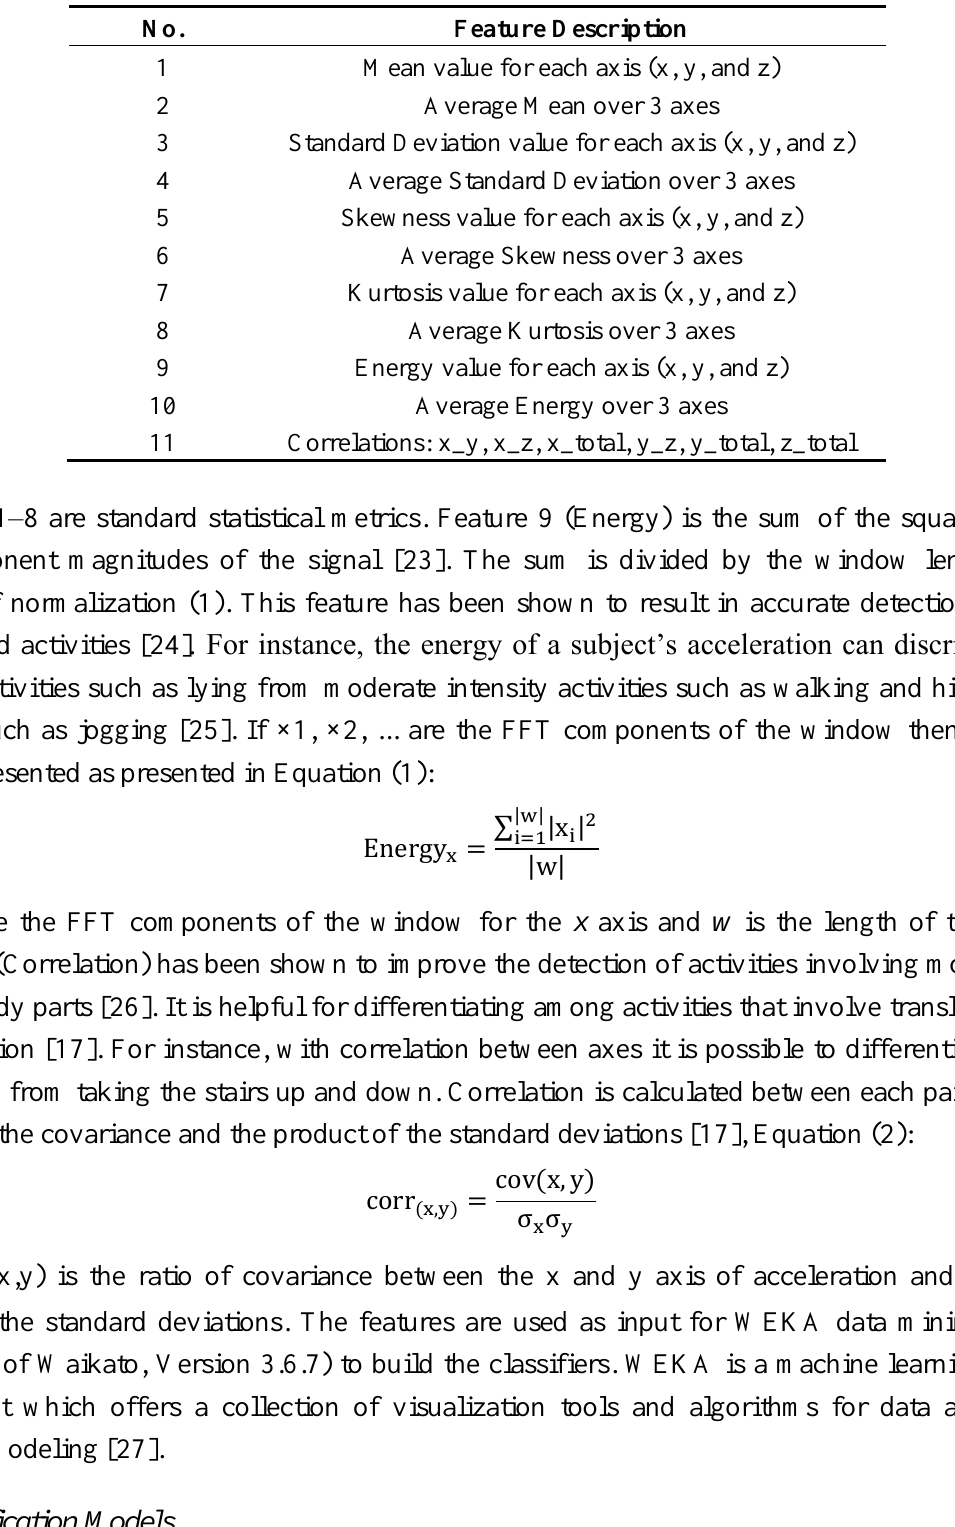
Table 3. Description of features extracted from each window of raw acceleration data. 11 features were extracted from each window, giving a total of 26